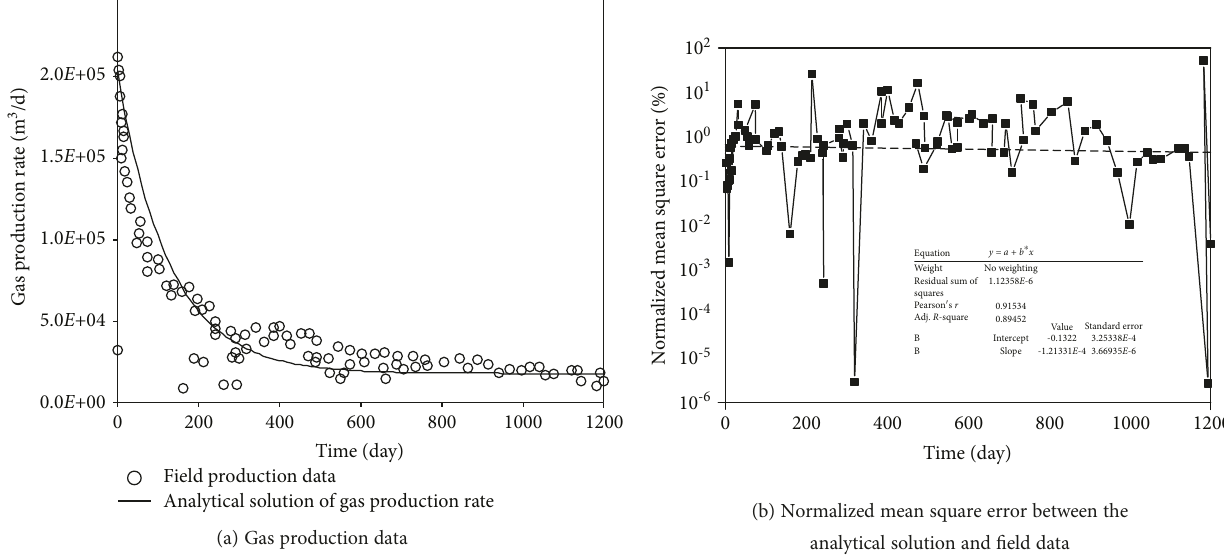
(b) Normalized mean square error between the analytical solution and fi eld data